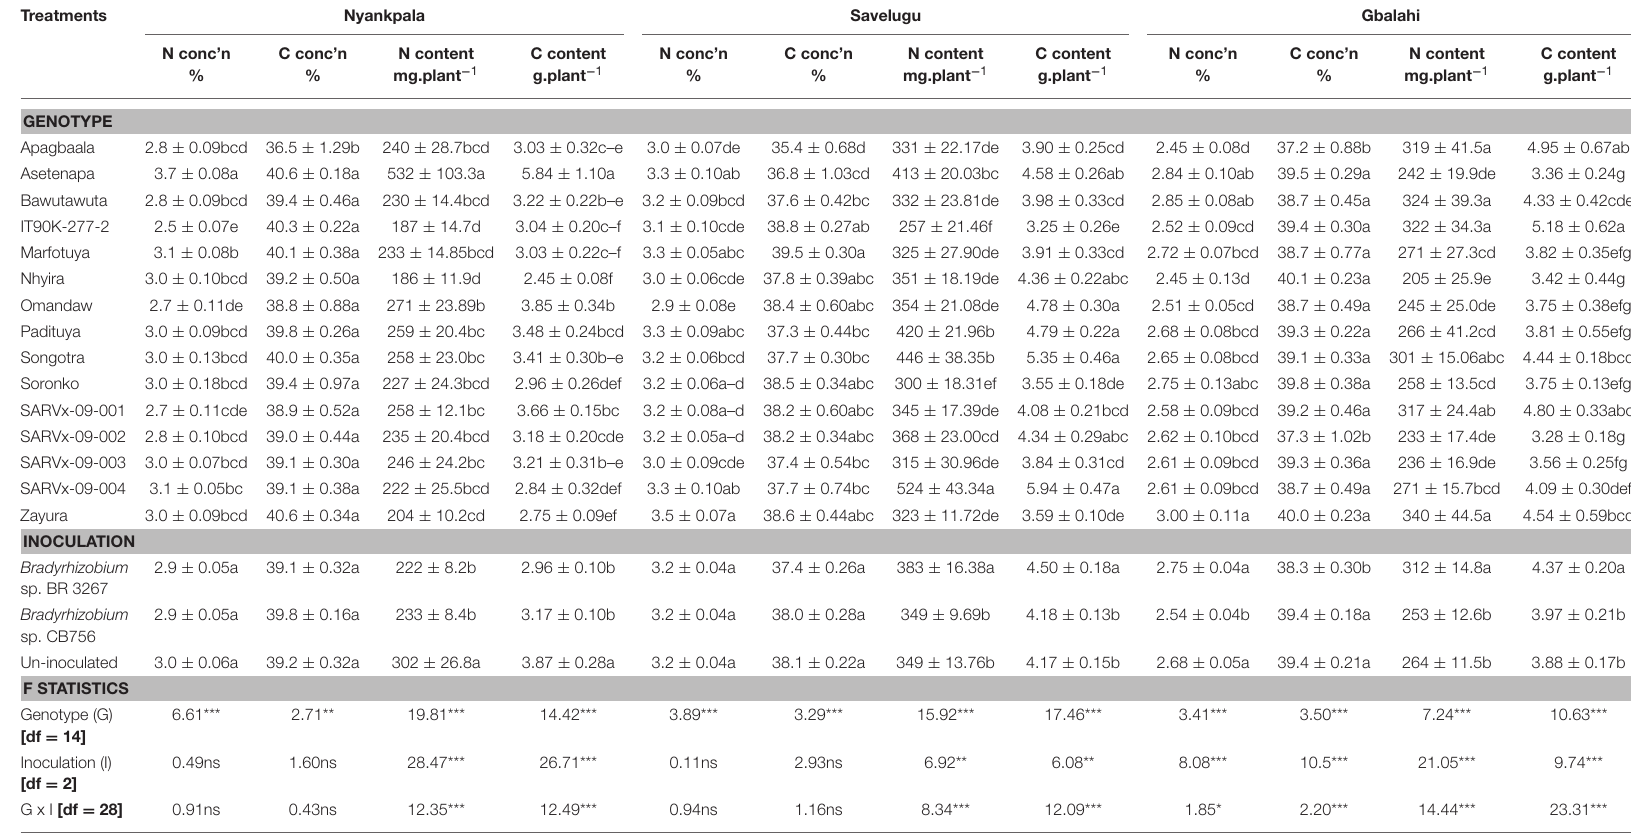
TABLE 6 | Shoot N and C assimilation in 15 cowpea genotypes inoculated with two Bradyrhizobium strains and planted in Nyankpala, Savelugu, and Gbalahi in 2013.